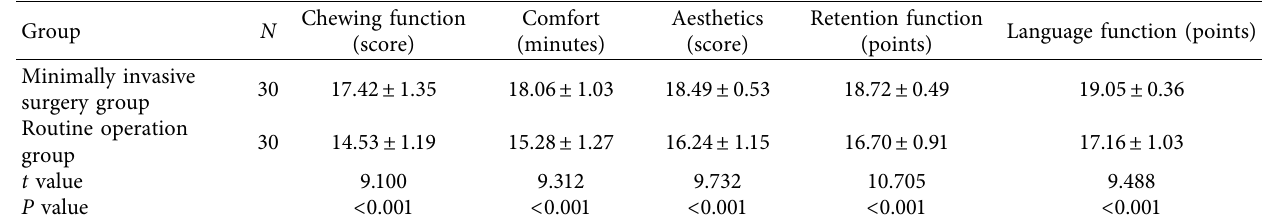
Table 3: Comparison of repair satisfaction scores between the two